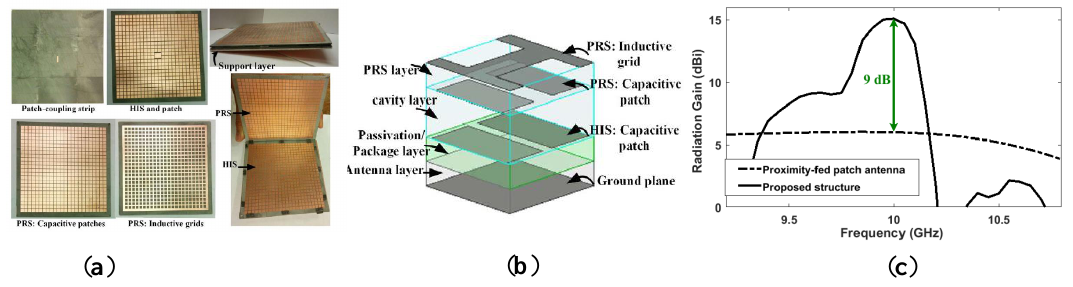
Figure 18. Configuration of the RCA in [153]: ( a ) Fabricated MEFSS cover; ( b ) MEFSS unit cell; ( c ) Radiation gain of the main radiator with and without MEFSS cover.